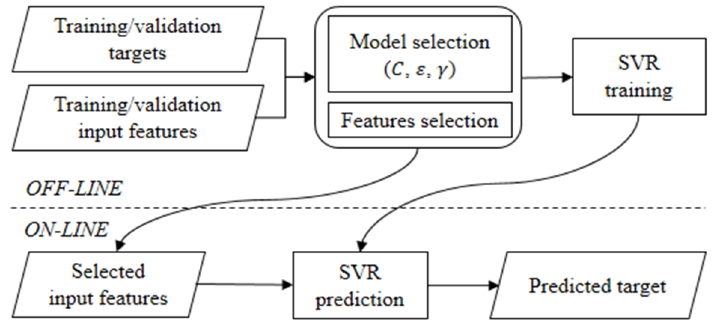
Figure 3. Support vector regression (SVR) general scheme separated between off-line and on-line phase. During the off-line phase the SVR is trained and the prediction function is estimated. The on-line phase refers to the operative part of the method, in which the prediction phase can accept a proper set of inputs for estimating the discharge in the target